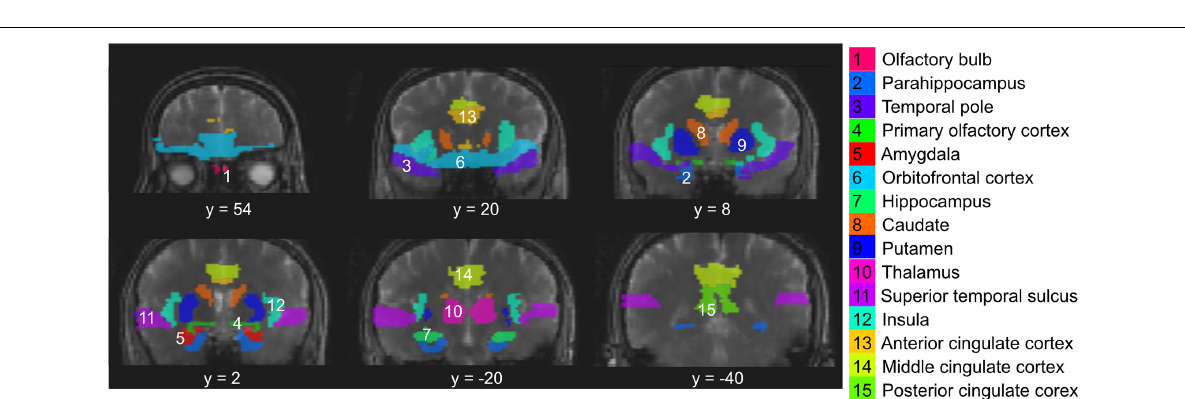
FIGURE 1 | Illustration of the olfactory paradigm used during fMRI. The odorant during the 60 s stimulus-on block was delivered in a pulsed pattern, with 1 s odorant of PEA and 2 s of odorless mineral oil (MO) repeated for 20 times. During the 120 s stimulus-off block, only MO was delivered continuously.